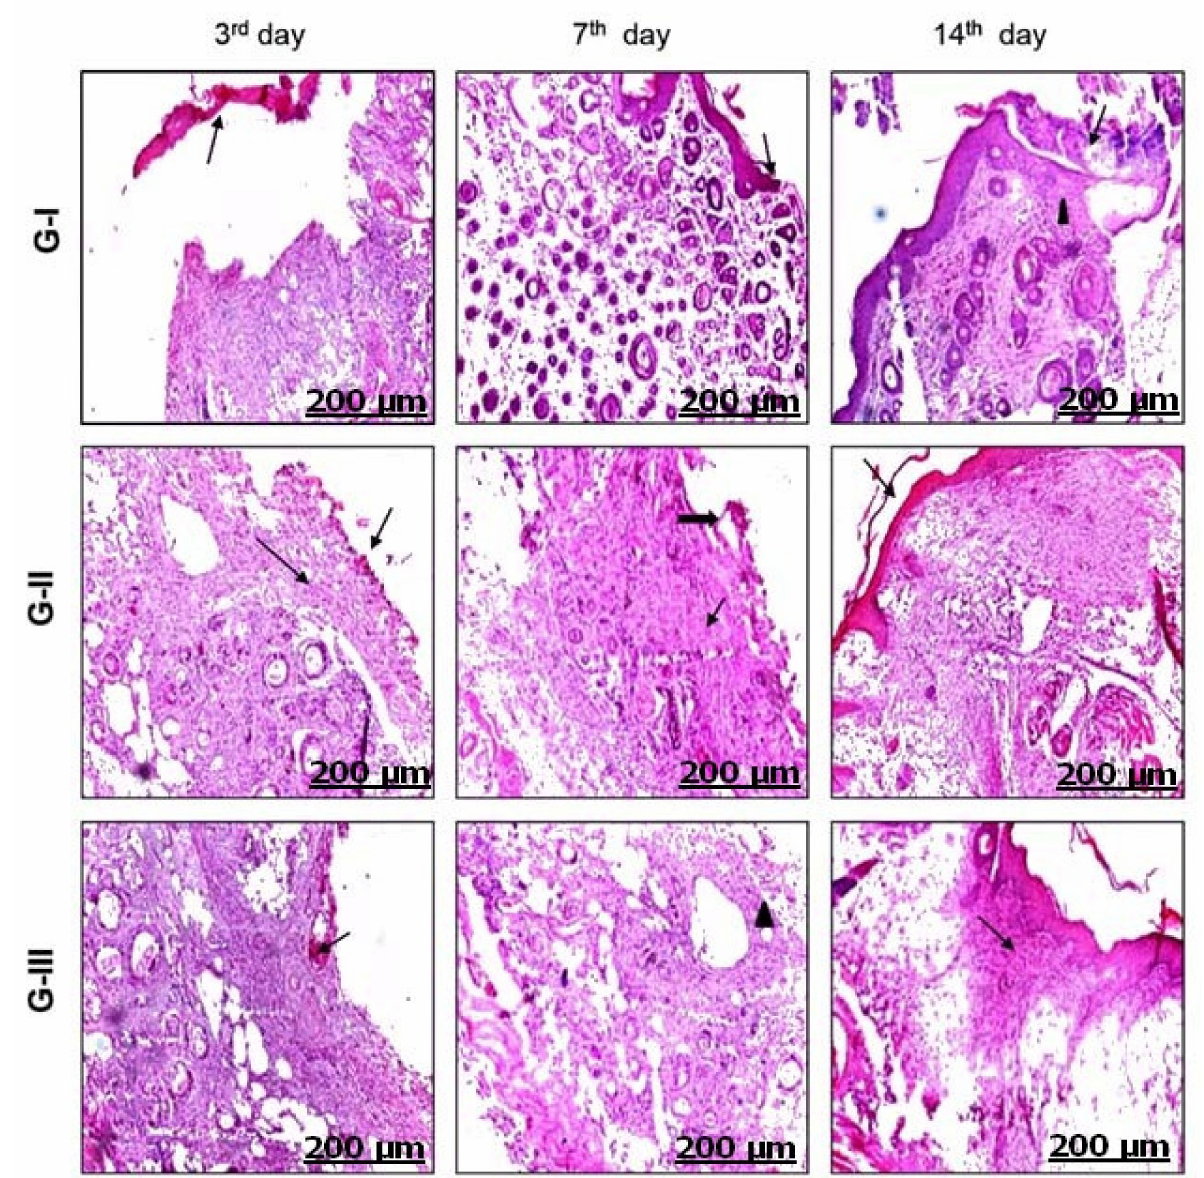
Figure 5. Photomicrograph of the control and treated groups on the 3rd, 7th, and 14th days post- treatment where GI at 3rd day showed ulcerated and desquamated necrotic tissue with inflammatory cells infiltration (arrows), while at 7th day, there were dilated blood vessels with epithelization. On 14th day, increased mononuclear inflammatory cells infiltration with necrotic tissue mass at the wound area was shown. While GII on the 3rd day showed inflammatory cells infiltration and mild angiogenesis, and on the 7th day, fibroblast proliferation with neovascularization and granulation tissue formation was shown. Moreover, on the 14th day, full skin thickness and healing near to normal skin were shown. GIII showed congested blood vessels with mild fibroblast proliferation on the 3rd day, while on the 7th day, increased fibroblast proliferation and neovascularization were shown. On the 14th day post-treatment, complete epithelization of wounds with mononuclear inflammatory cells infiltration was